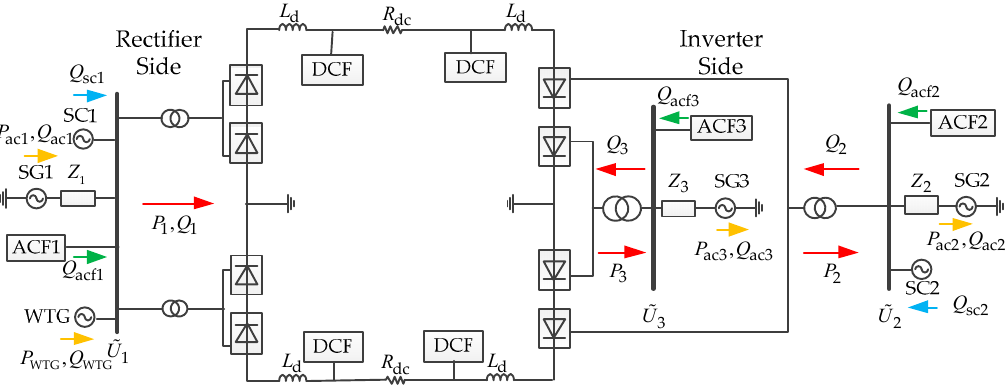
Figure 6. Structure of the test ultra-high-voltage direct current (UHVDC) system. Figure 6 . Structure of the test ultra-high-voltage direct current (UHVDC) system. Table 3. System parameters and control Table 3 . System parameters and control modes.